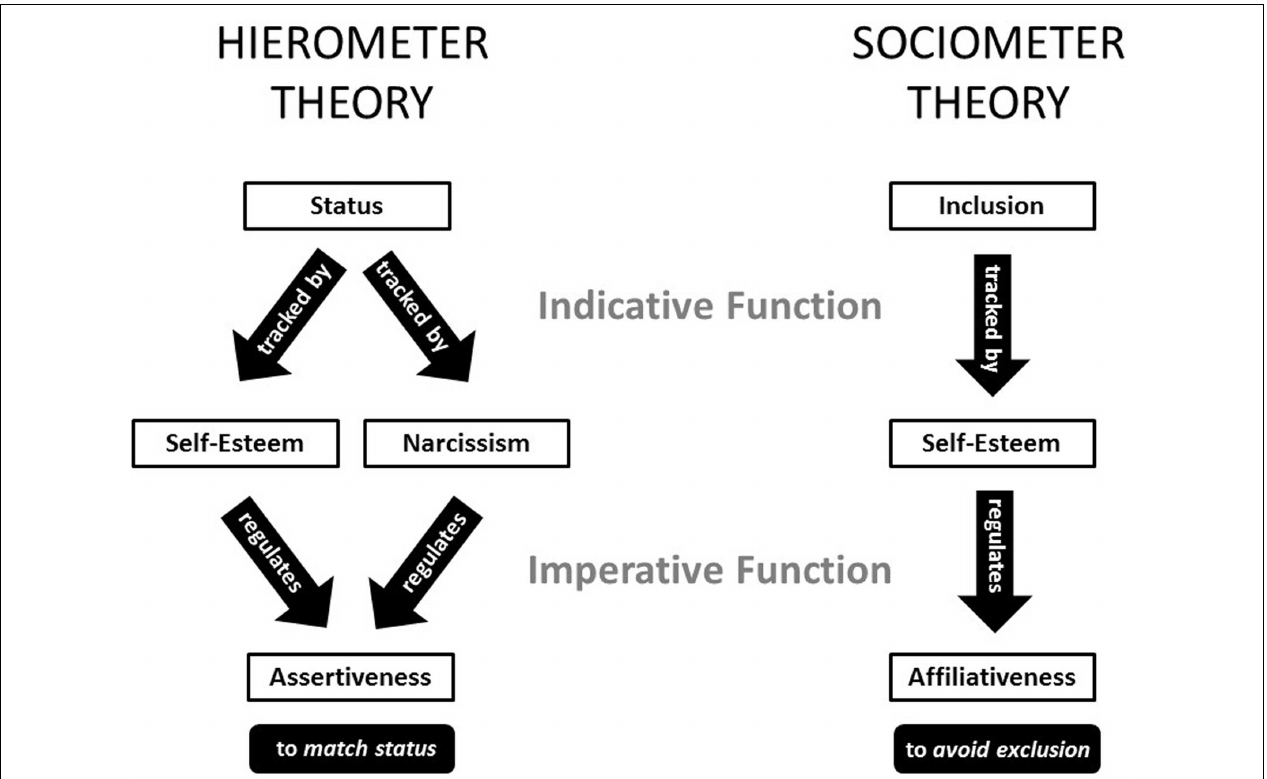
FIGURE 1 | A side-by-side illustration of the hypothesized dynamics of hierometer theory and (the original version of) sociometer